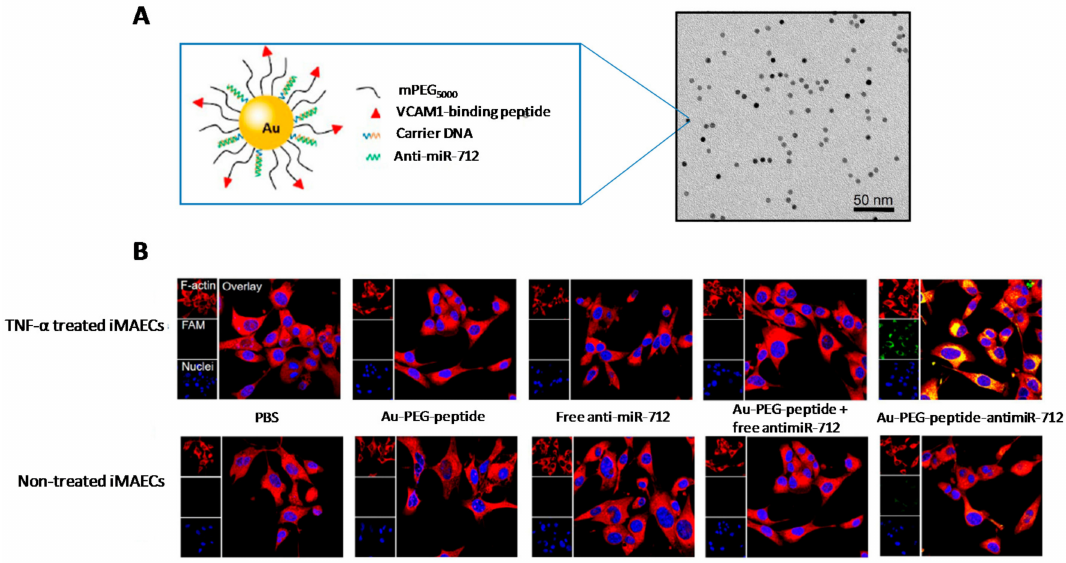
Figure 9. ( A ) Design and a TEM image of the AuNP conjugates decorated with VCAM1 binding peptide and anti-miR-712. ( B ) Confocal images of iMAECs which show the ability of the AuNPs to impart cellular uptake as well as the release of the fluorescently labelled anti-miR-712 and duplex formation with the corresponding target. This effect was not observed in non-expressing VCAM1 endothelial cells. Adapted with permission from [229]. Copyright 2016, Wiley-VCH Verlag GmbH&Co. KGaA,